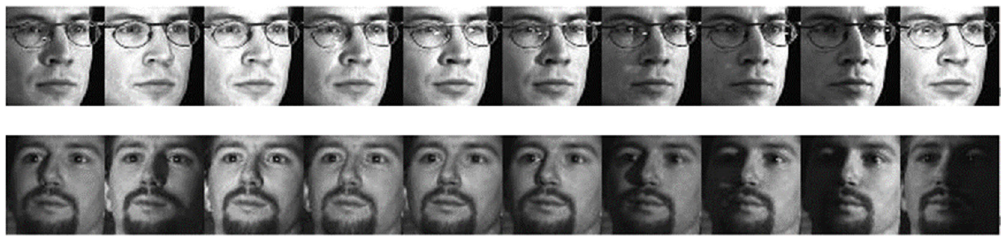
Figure 7. Examples of the PIE face database.